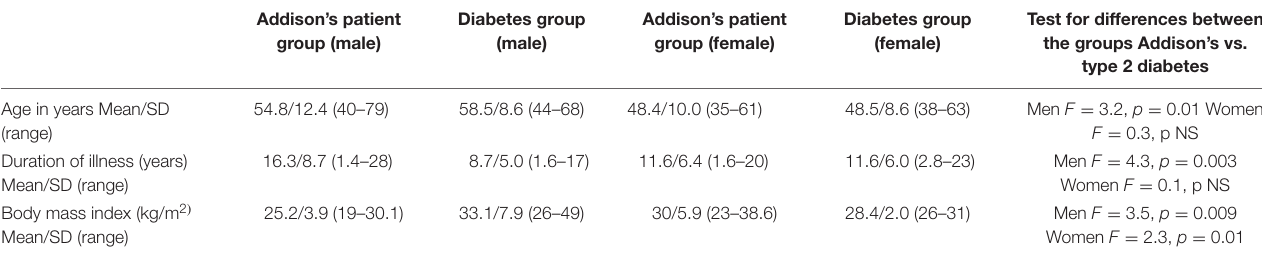
TABLE 1 | Comparison of age, duration of illness, and body mass index, between the Addison’s patient group and type 2 diabetes group.